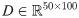
Average reconstruction error ESNR in sparse representation using dictionary learnt by K-SVD (non-solid lines) and R-SVD (solid lines), for L = 10000 synthetic vectors varying the additive noise power (in the legend).Averages are calculated over 100 trials and plotted versus update iteration count. Left: D∈R50×100 with sparsity k = 5, Right: D∈R100×200 with sparsity k = 10.